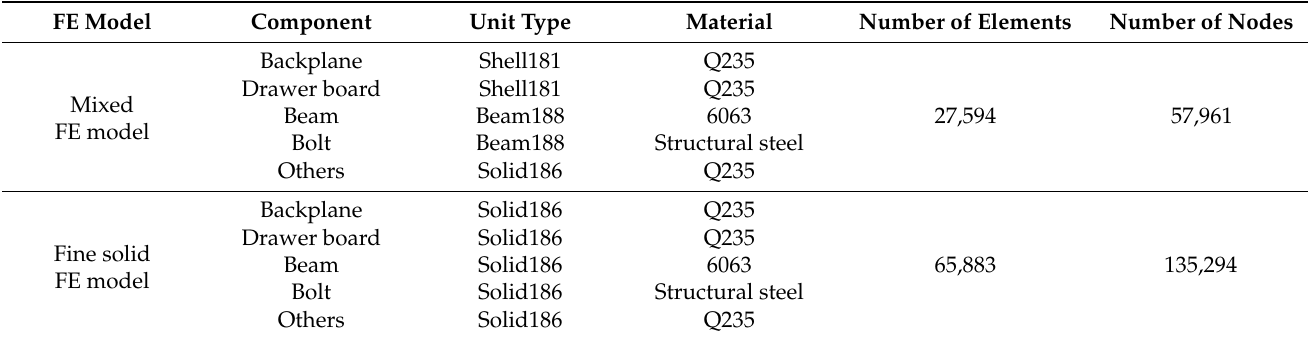
Table 1. Specific settings of two FE models of the experimental rack simulator.